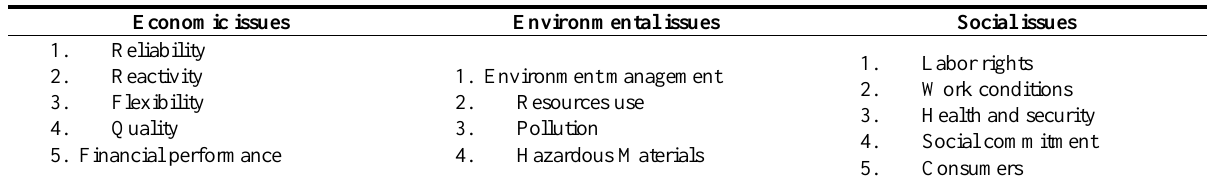
Table 2 . Main issues which characterize supply chain global